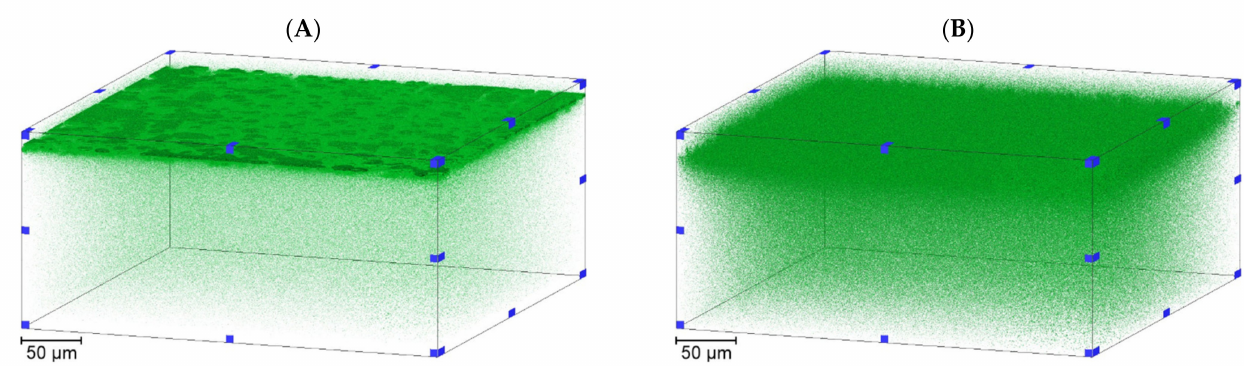
Figure 5. Confocal microscopy imaging of membranes following dyed liposome filtration. ( A ) A 3D render of the upstream membrane. ( B ) A 3D render of the downstream membrane. Filtration was performed at a constant differential pressure of 0.14